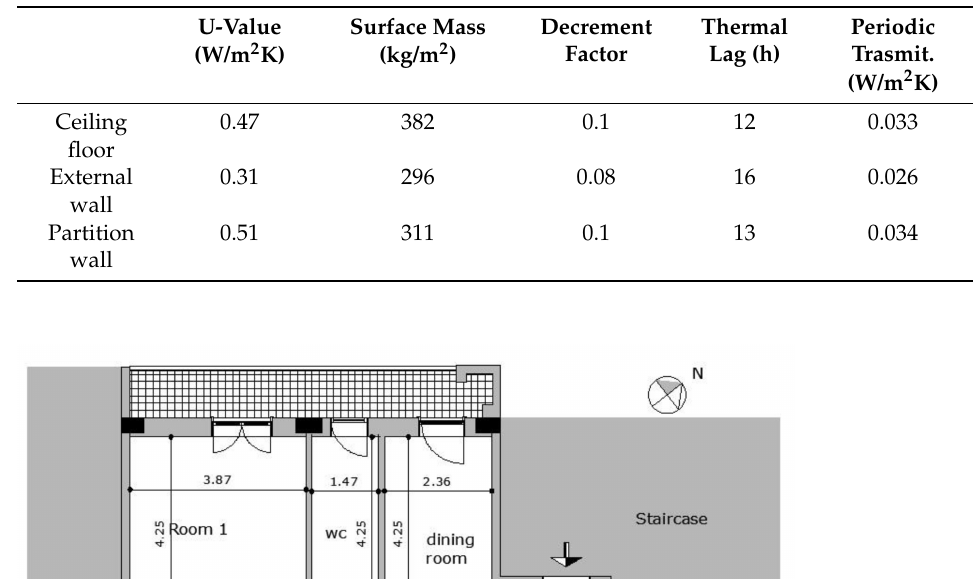
Table 5. Thermal characteristics of building envelope.